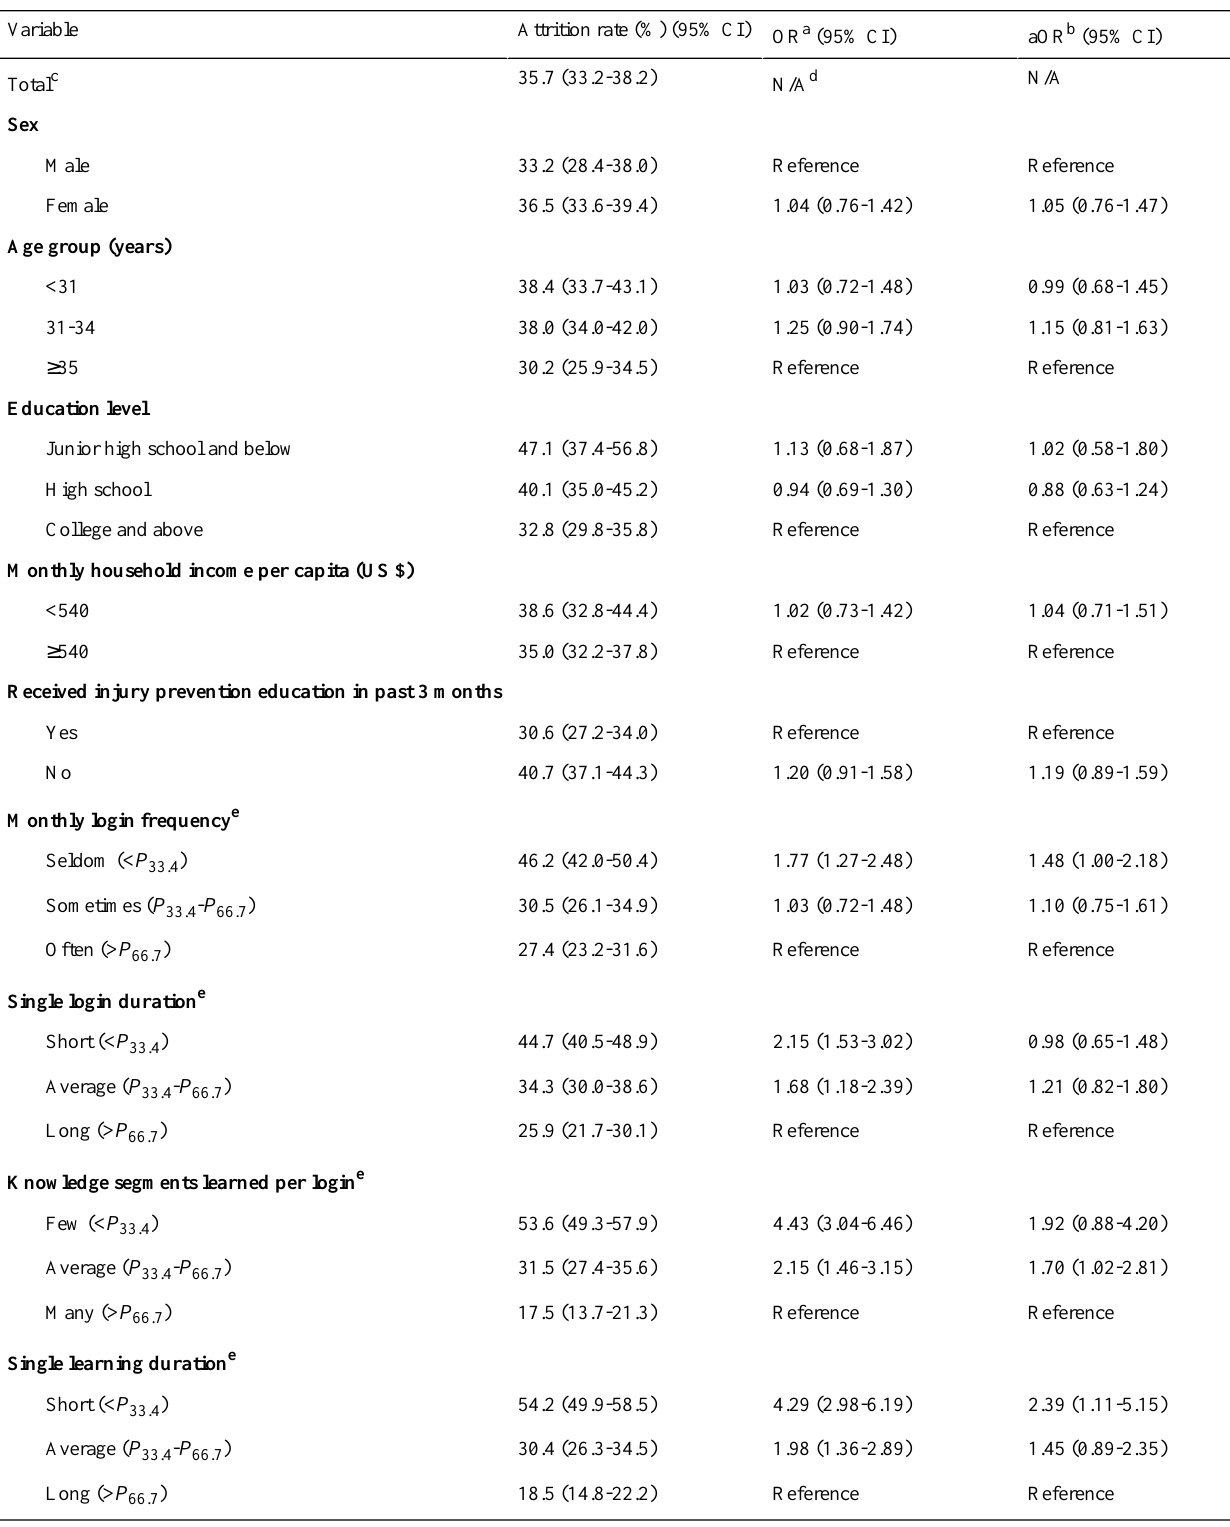
Table 4. Six-month attrition rates of caregivers of preschoolers in the control group